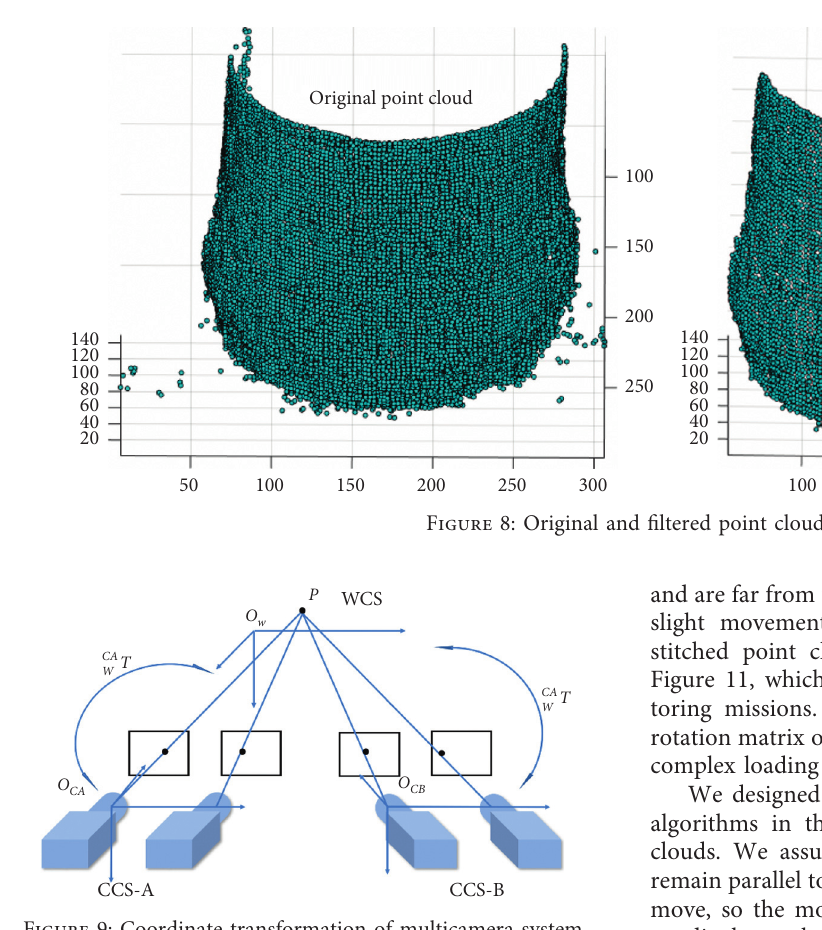
Figure 9: Coordinate transformation of multicamera